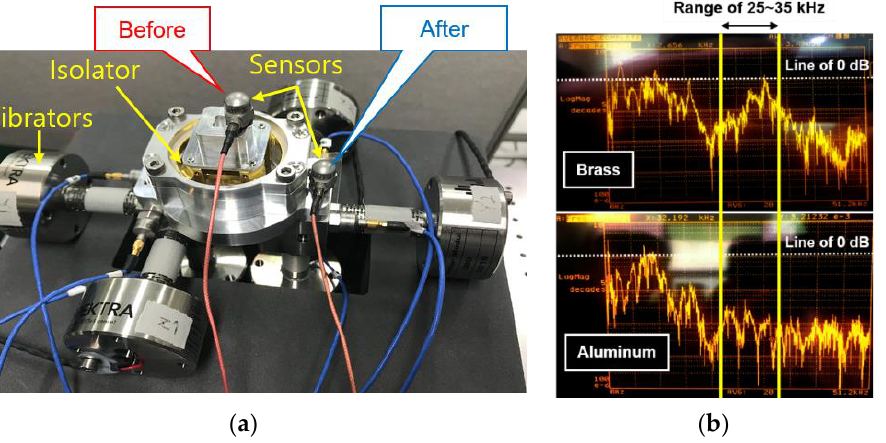
Figure 13. Test using high-frequency vibration equipment: ( a ) equipment; ( b ) oscilloscope result.